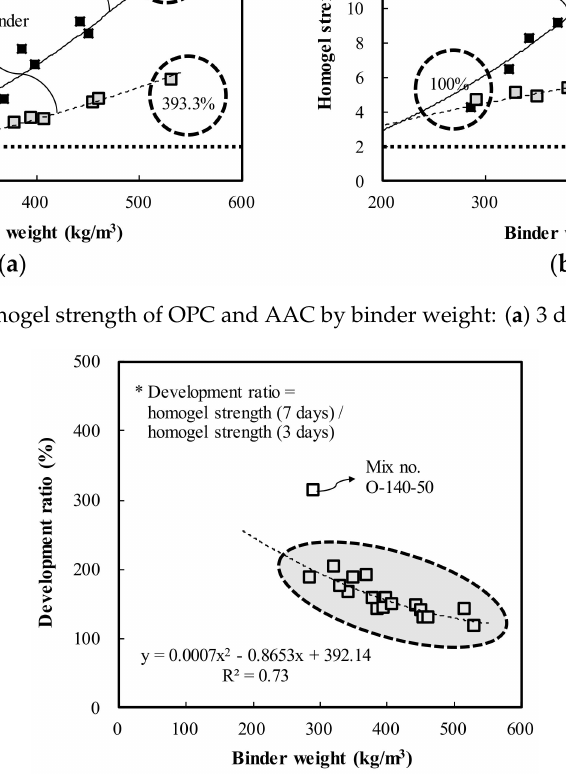
Figure 7. Development ratio of OPC and AAC by binder weight.